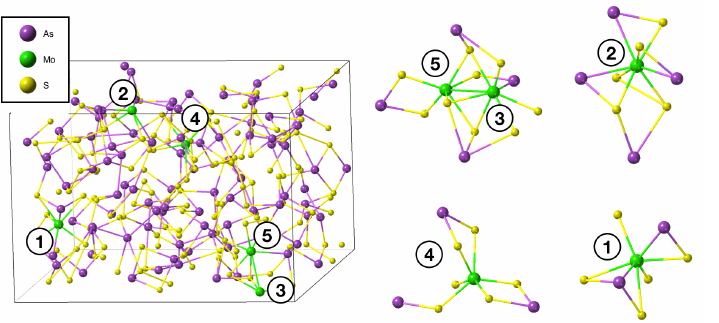
Figure 2. Melt-quenched a-As 2 S 3 :Mo obtained from AIMD simulations ( left ) and fragments of the structure centered around the Mo atoms ( right ). Mo atoms in the a-As 2 S 3 structure are numbered from 1 to 5 (left panel). In the right panel, local structures around these atoms are shown. As atoms— violet; S atoms—yellow; Mo atoms—green.